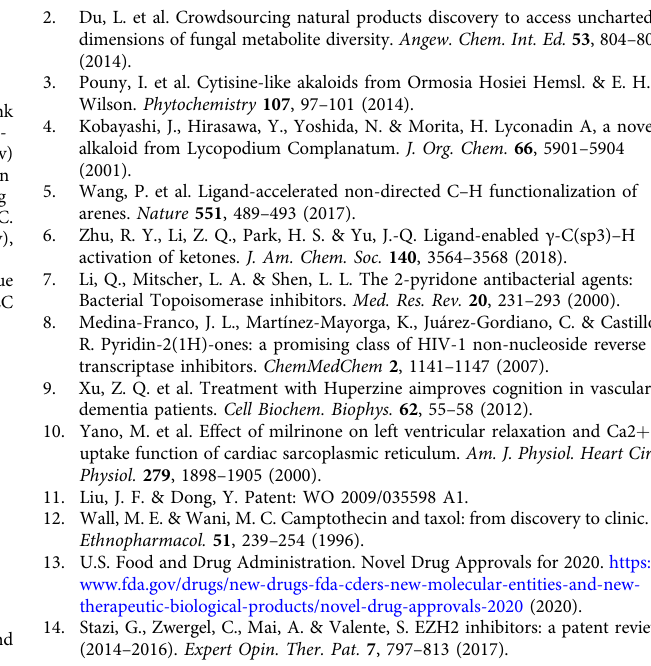
Fig. 4 Diversity-oriented functionalization of uracils. A Preparation of thymine derivatives and analogs. B Selected antiviral agents derived from uracil with C-5 and C-6